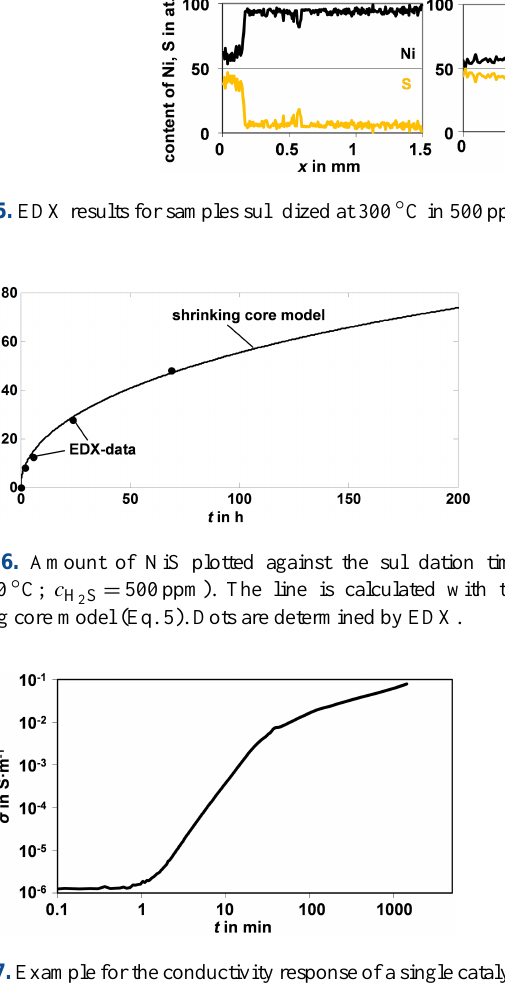
Figure 9. Phase angle during sulfidation under 1000ppm H 2 S in N 2 at different temperatures. For the temperature curves at 100 and 150 ◦ C, the measured values were averaged over 10